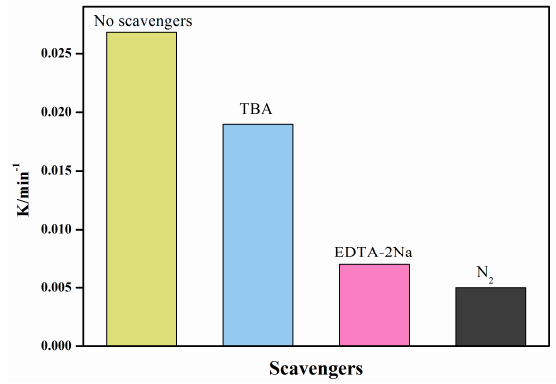
Figure 11. First-order rate constant values of photogenerated active species trapped in the system of photocatalytic degradation of MB by Cu 2 O/ZnWO 4 under visible